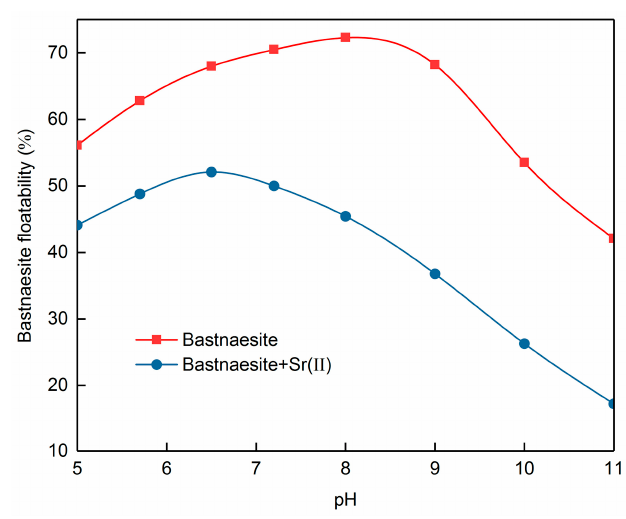
Figure 1. Floatability of bastnaesite with salicylhydroxamic acid (SHA) as the collector, in the absence and presence of strontium ions at different pH (strontium ions: 1 × 10 − 4 mol/dm 3 , SHA: 5 × 10 − 4 mol/dm 3 ).